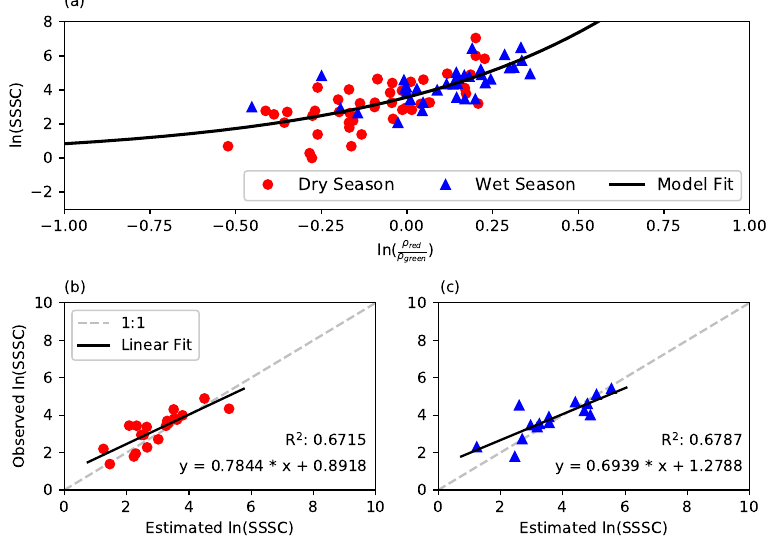
Figure 5. Model calibration using the ρ Red band ratio with a exponential fit from Equation (1) ( a ) and ρ Green validation ( b , c ) plots of statistical modeling for the dry ( b ) and wet ( c ) seasons.